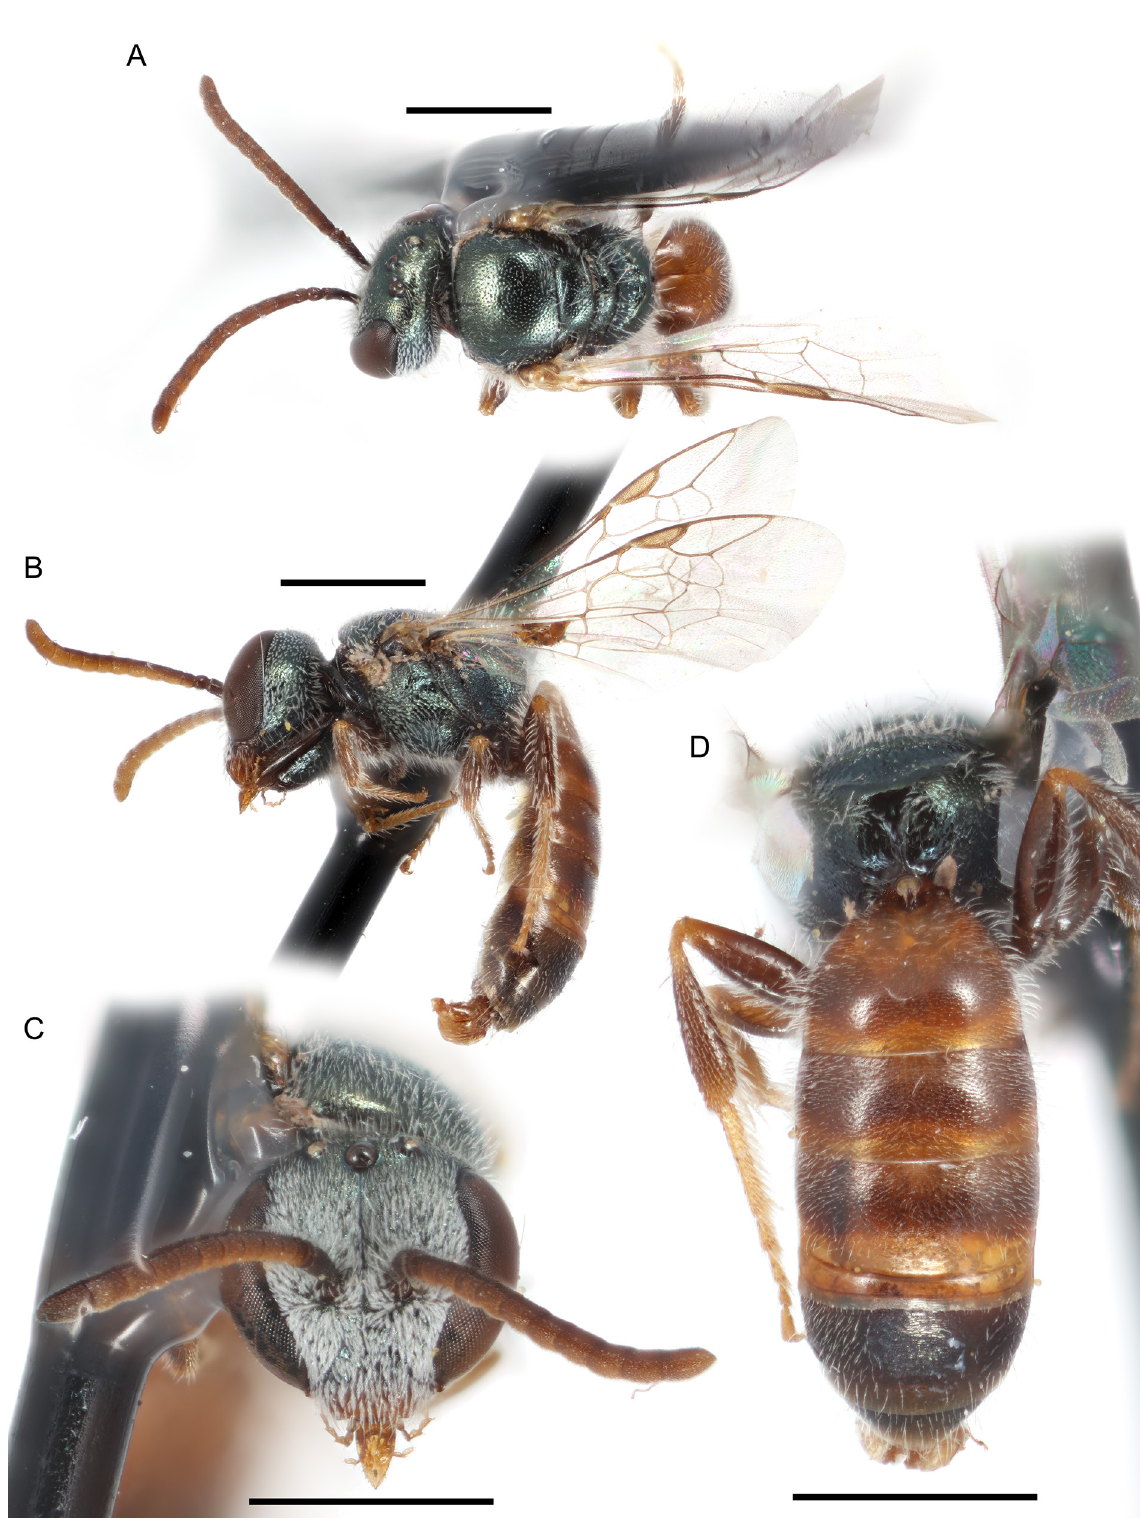
Fig. 65. Lasioglossum ( D. ) minckleyi sp. nov., ♂. A . Dorsal habitus. B . Lateral habitus. C . Face. D . Propodeum and metasoma. Scale bars: 1